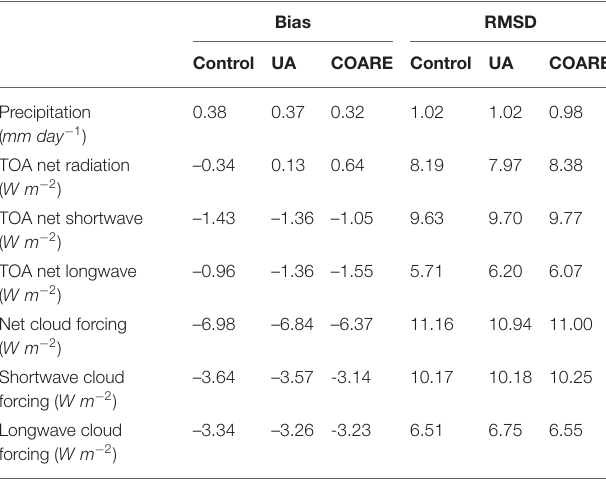
TABLE 4 | Global mean and global root-mean-square (RMS) of annual mean differences between model and observations.